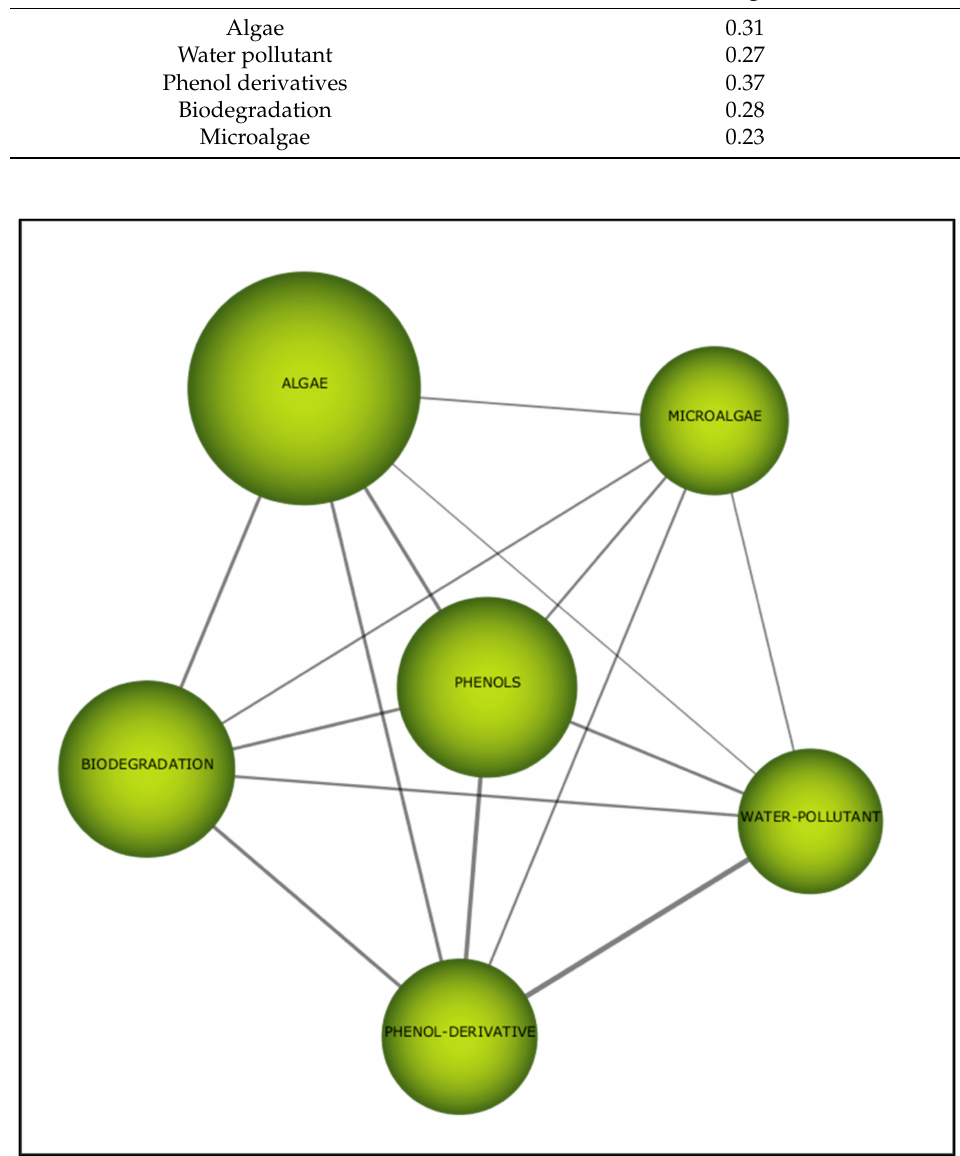
Figure 14. Thematic network for the fourth period